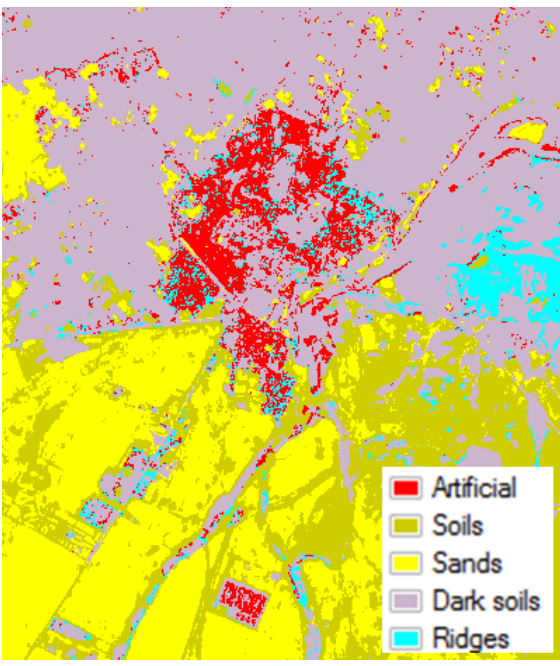
Figure 6. Erfoud town satellite imagery classification